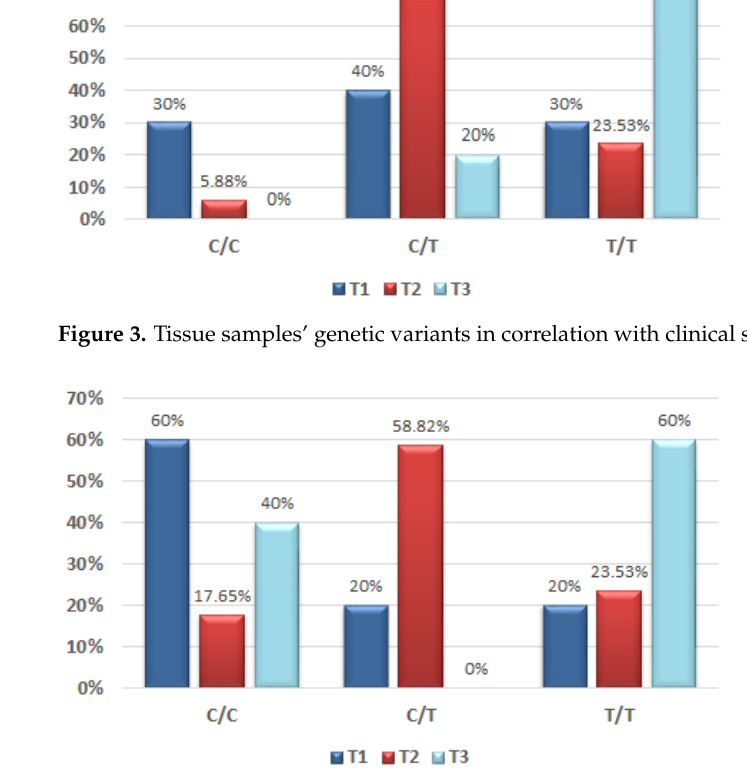
Figure 4. Blood samples’ genetic variants in correlation with clinical staging.